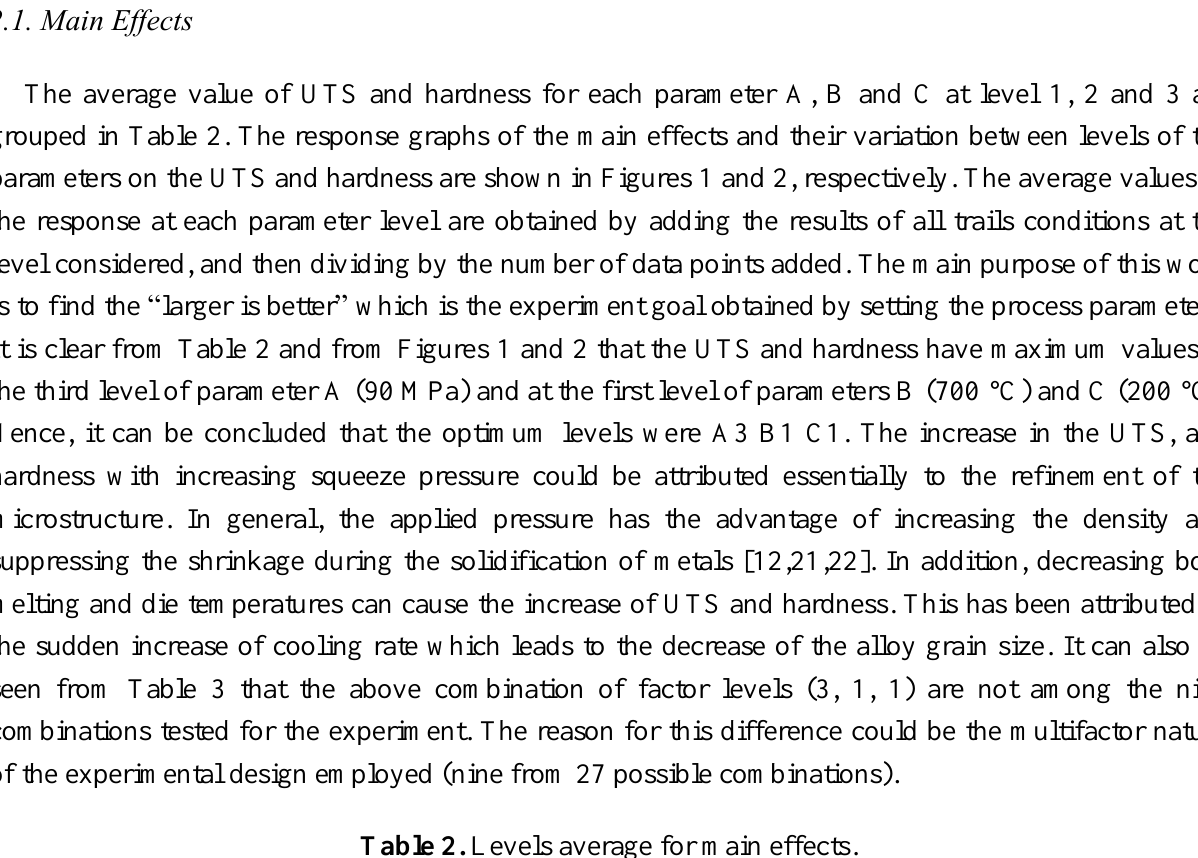
Table 1. Results of L